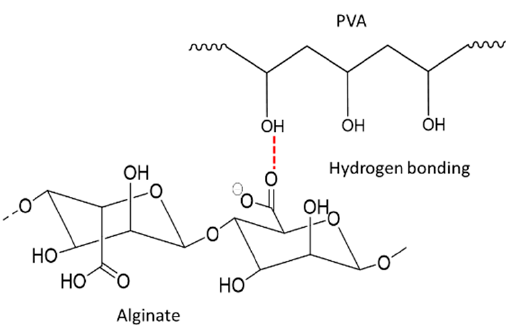
Figure 11. Proposed illustration of alginate interaction PVA via H-bond. Figure 10. Illustration of sericin, alginate, and anthocyanin interactions ( a ) Sericin-anthocyanin in- teraction: hydrogen bonding ( b ) Sericin–alginate interaction: electrostatic interaction.